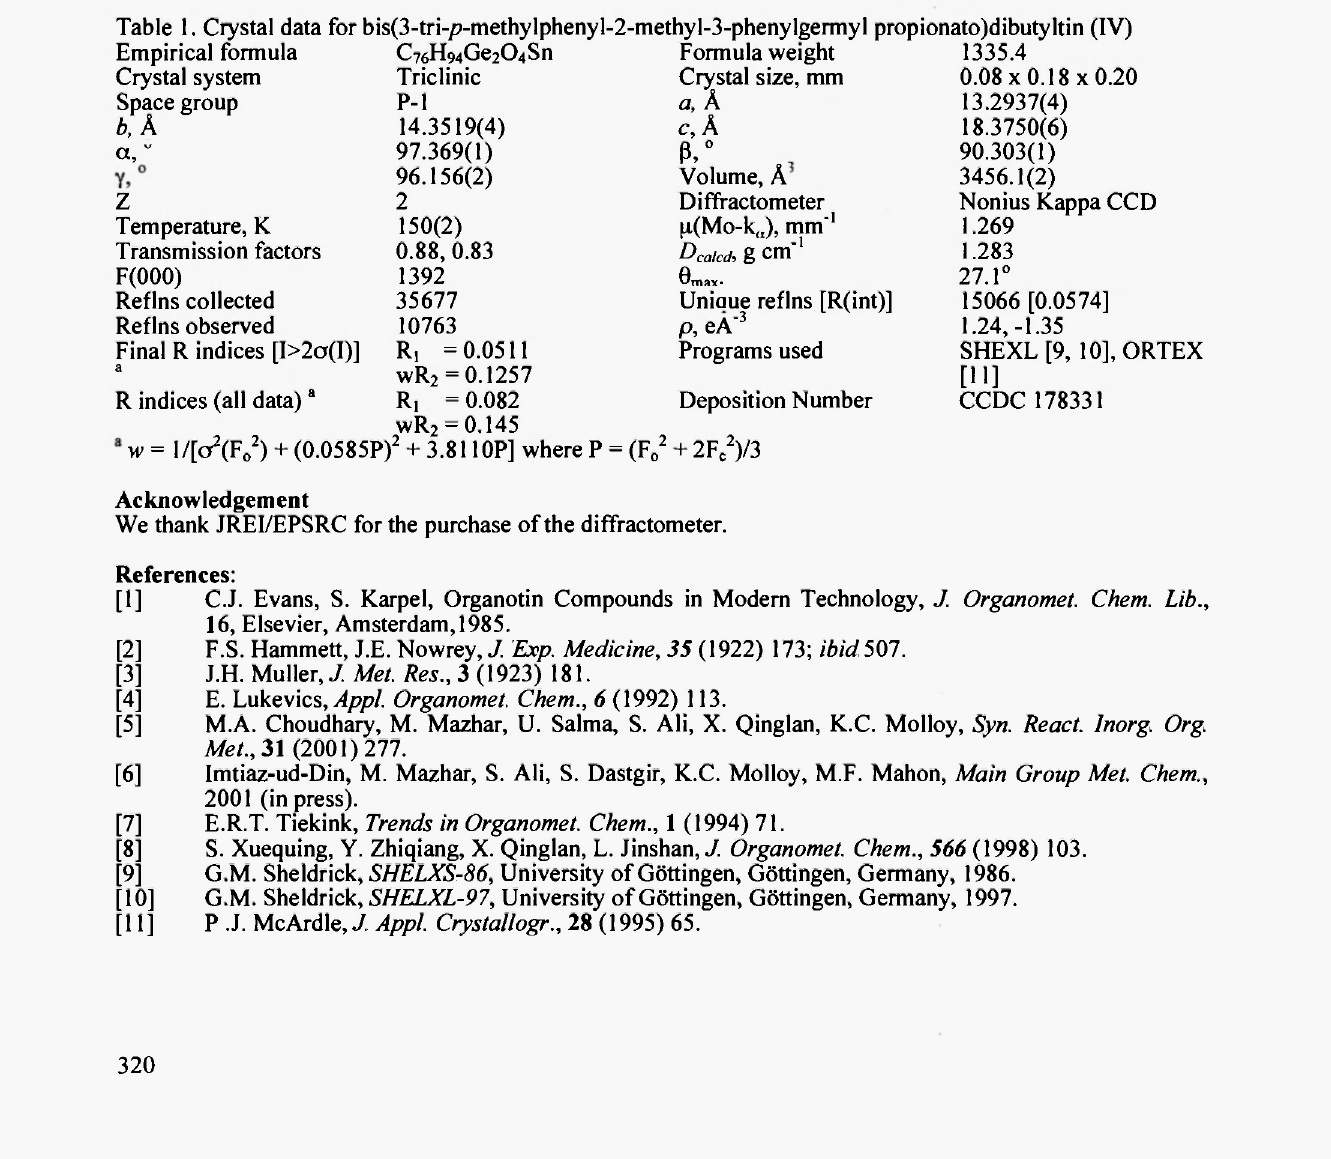
Table 1. Crystal data for bis(3-tri-£>-methylphenyl-2-methyl-3-phenylgermyl propionato)dibutyltin (IV) Empirical formula Crystal system Space